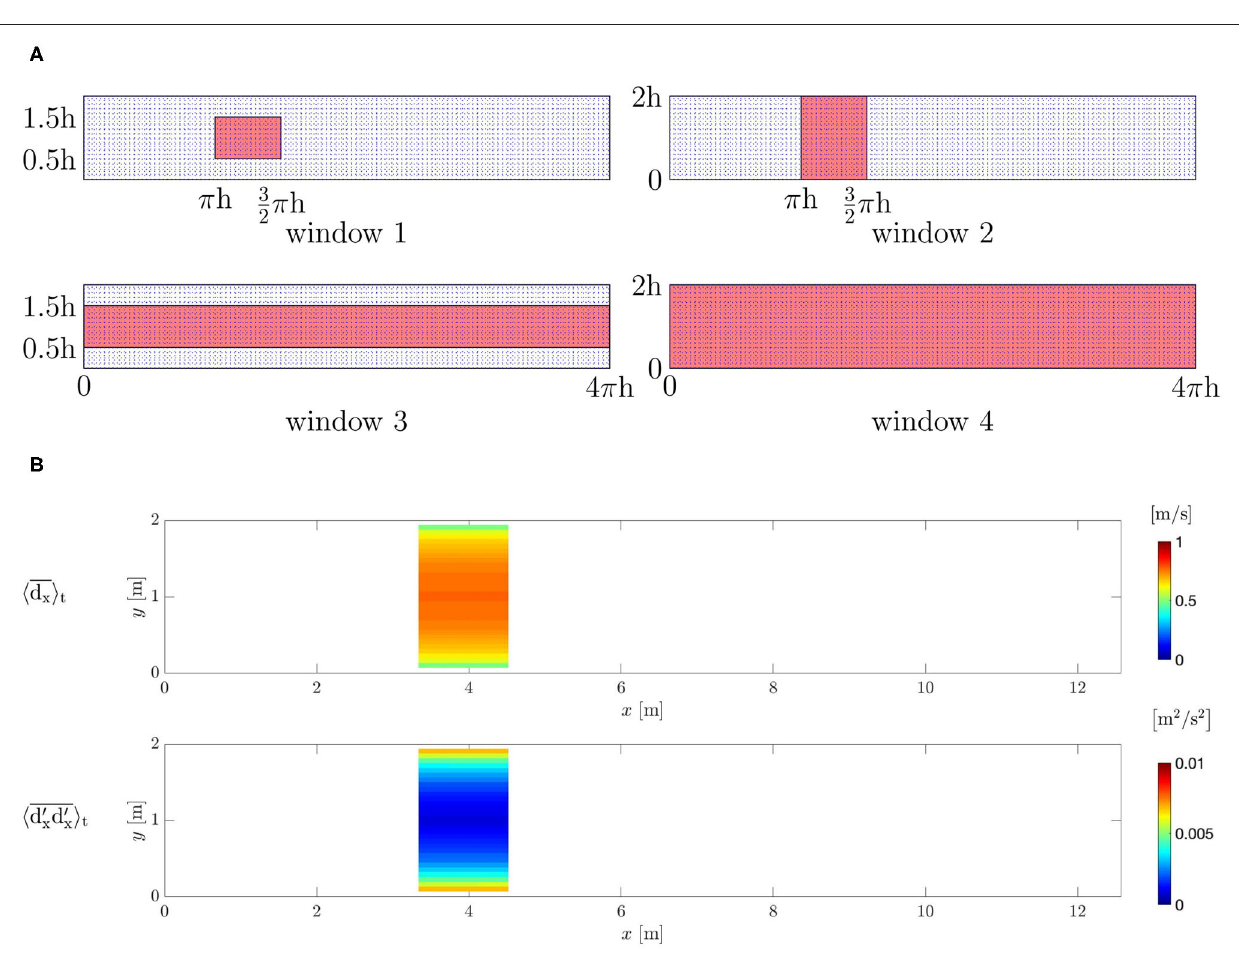
windows. The results are in good agreement with the ground truth, even though they are slightly underestimated. The value of the TKE computed in the DA predictions are also good for all configurations. The values of TKE stabilize around 0.55 [m 2 /s 2 ]